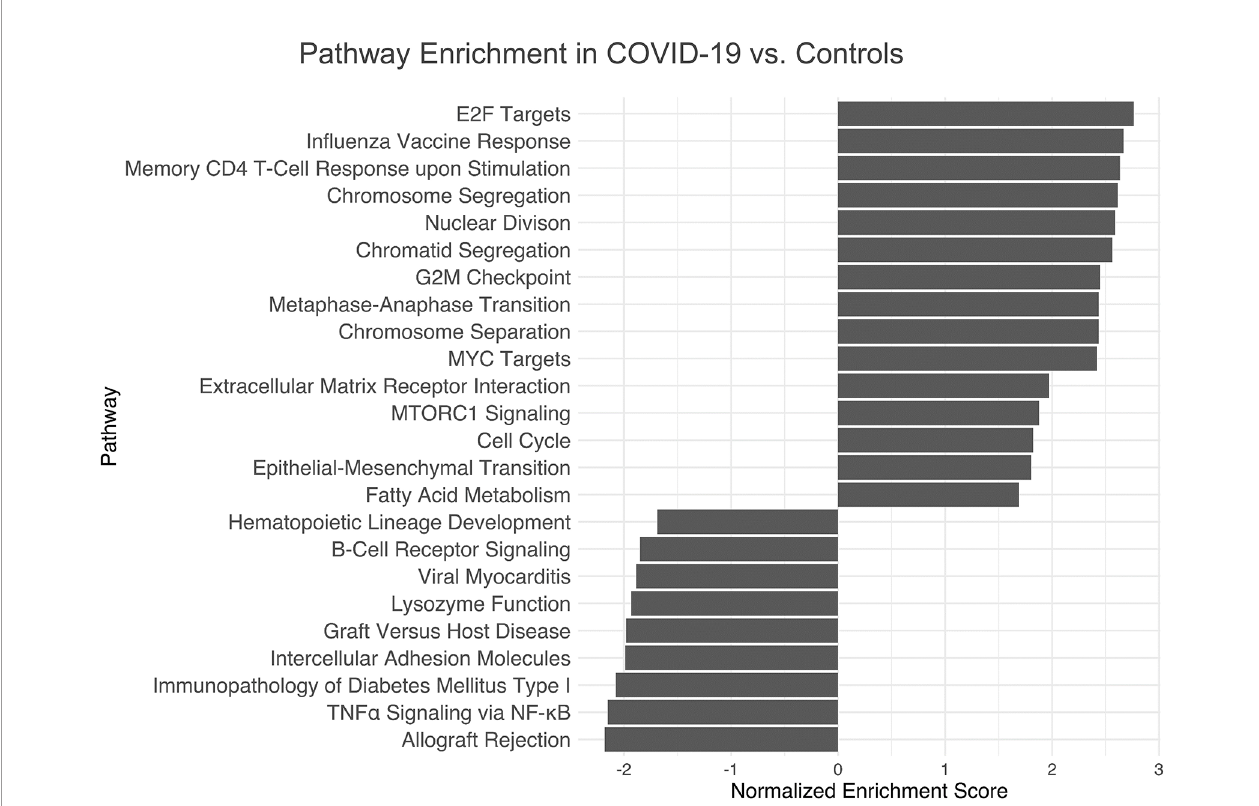
FIGURE 5 | Pathway Enrichment Analysis of Gene Expression Pro fi ling in COVID-19 Immunology. Top up- and downregulated pathways of the GSEA, Hallmark and KEGG database with an abs(NES) > 1. Cell cycle and memory T-cell-response upon in fl uenza vaccine-stimulation, MYC targets and mTORC1-signaling as well as epithelial-mesenchymal transition and fatty acid metabolism related pathways are signi fi cantly upregulated in COVID-19, while pathways involving hematopoietic cell lineage development, B-cell receptor signaling, lysosome functions, leucocyte adhesion, TNF a signaling via NF- k B and allograft rejection are downregulated. Further details are found in Supplementary Materials, Table 2